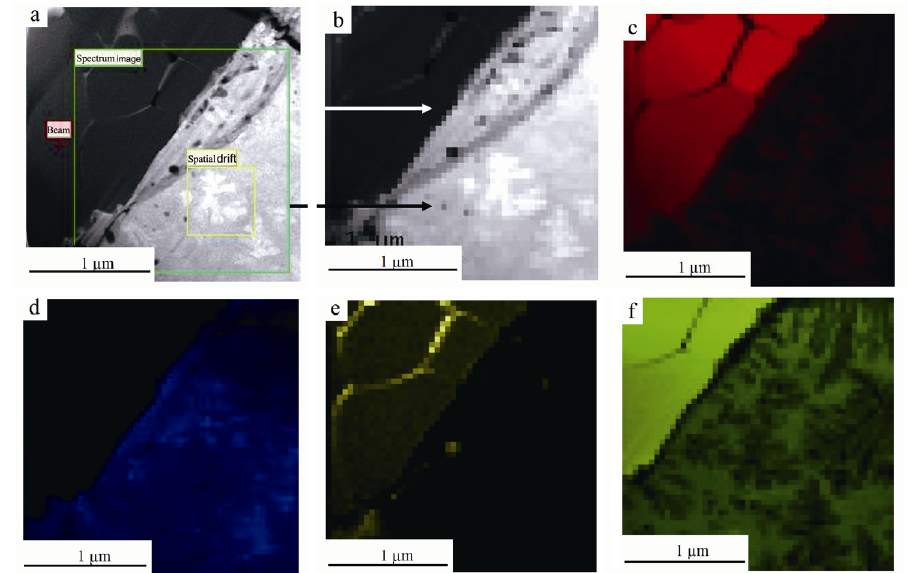
Fig. 6 (a) STEM − HAADF image showing where spectrum image area was acquired from (b) spectrum image; STEM − SI − EELS elemental mapping of (c) Si–L 2,3 , (d) Ti–L 3,2 , (e) O–K, and (f) N–K edges.